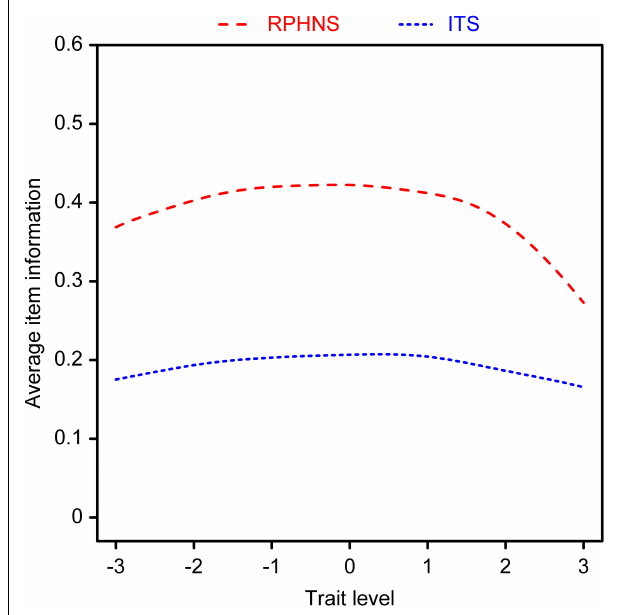
FIGURE 3 | Average item information